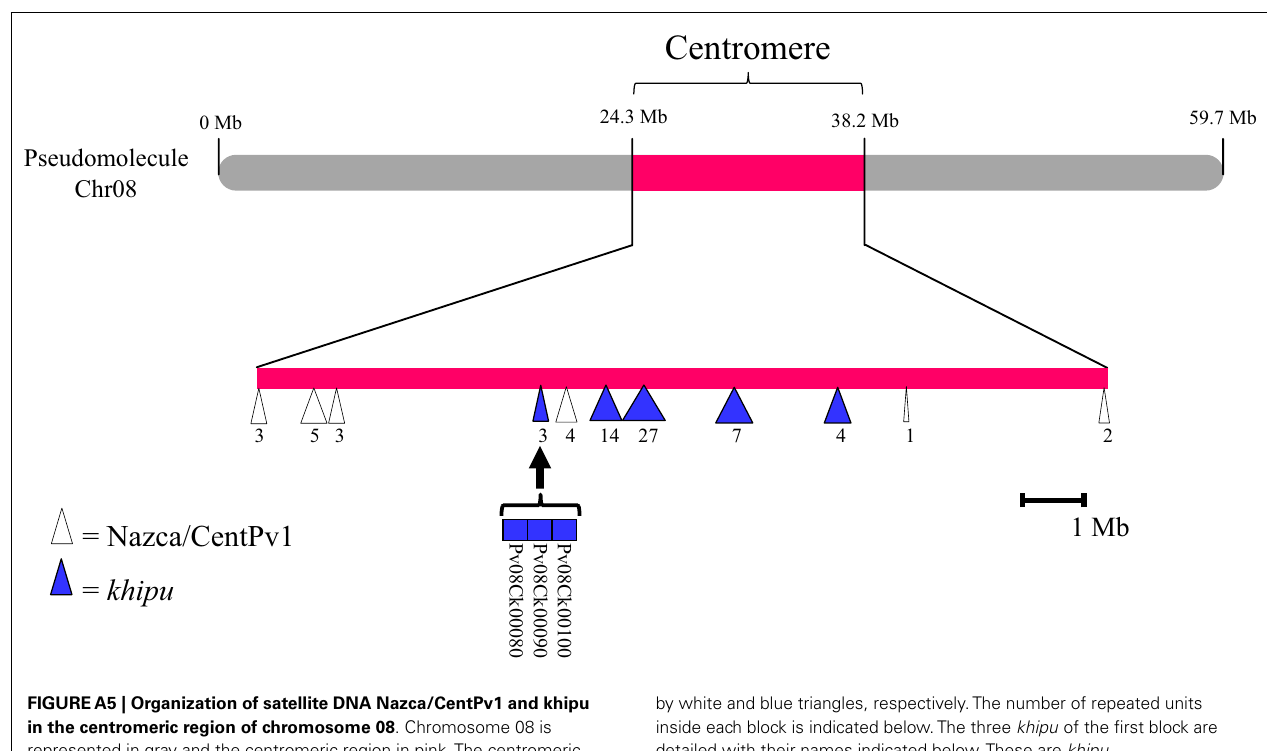
FIGUREA5 | Organization of satellite DNA Nazca/CentPv1 and khipu in the centromeric region of chromosome 08 . Chromosome 08 is represented in gray and the centromeric region in pink.The centromeric part is enlarged for positioning satellite DNA. Nazca/CentPv1 (centromeric repeat, Iwata et al., submitted) and khipu are represented